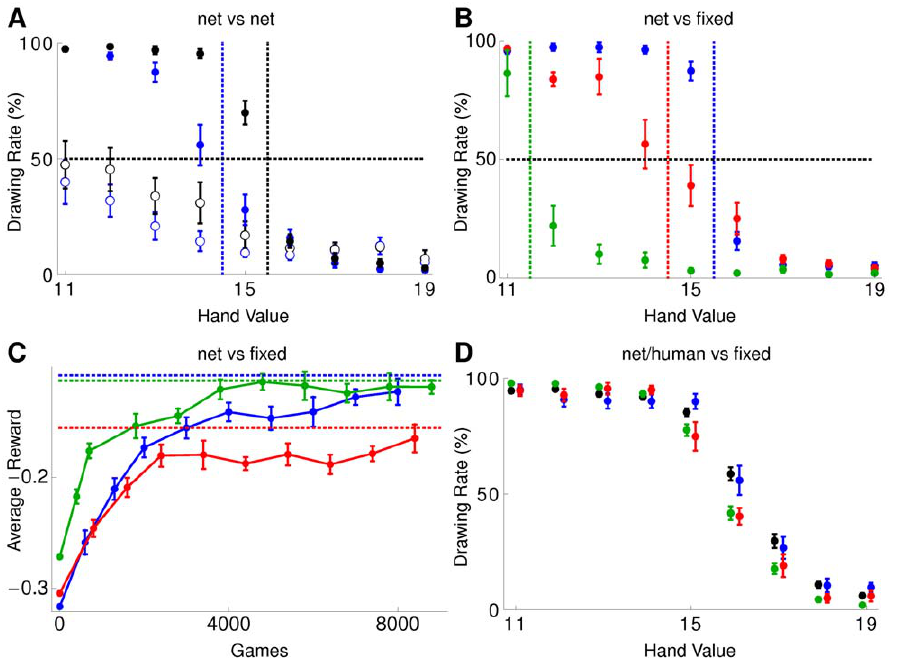
Figure 2. Playing blackjack with pRL converges toward pure Nash equilibrium. (A) Average strategy ( + SEM ) after 500 (open circles) and 10000 (filled circles) games where the gambler (blue) is a neural net as well as the croupier (black). The dotted vertical lines left of s 1 ~ 15 and s 2 ~ 16 show the separation line of drawing/not drawing another card for the optimal Nash strategy pair. (B) Average strategy ( + SEM ) after 10000 games for a neural net as gambler playing against a croupier that follows a given strategy s 2 ~ 15 (blue), 16 (red) or 17 (green). The colored dotted lines left of s 1 ~ 12,15,16 show the separation line of drawing/not drawing another card for the optimal strategy given that the croupier stops drawing at s 2 ~ 17,16,15 (from left to right). (C) Average reward ( + SEM ) of the gambler for the scenario described in (B). The colored dotted lines show the maximal reachable average reward. (D) Average strategy ( + SEM ) over the last 100 out of a total of 880 games for a neural net (red) or human (green) as gambler playing against a croupier that follows a given strategy s 2 ~ 15 . The initial weights of the network were chosen such that the strategy in the first 100 trials (blue) mimics the strategy of humans instructed about the game rules